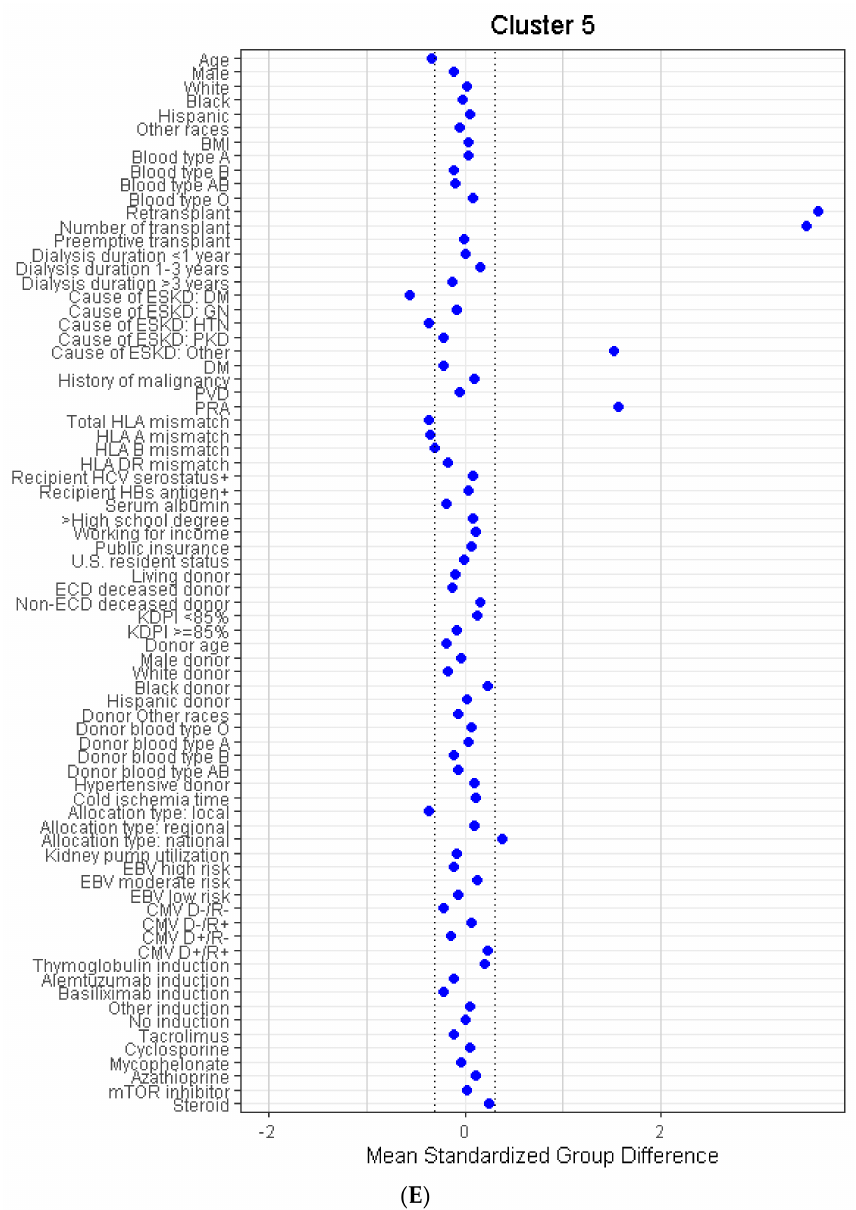
Figure 3. ( A ) The standardized differences in cluster 1 of morbidly obese kidney transplant recipients for each of the baseline parameters. ( B ) The standardized differences in cluster 2 of morbidly obese kidney transplant recipients for each of the baseline parameters. ( C ) The standardized differences in cluster 3 of morbidly obese kidney transplant recipients for each of the baseline parameters. ( D ) The standardized differences in cluster 4 of morbidly obese kidney transplant recipients for each of the baseline parameters. ( E ) The standardized differences in cluster 5 of morbidly obese kidney transplant recipients for each of the baseline parameters. The x axis shows the standardized differences values, and the y axis shows baseline parameters. The dashed vertical lines represent the standardized differences cutoffs of < − 0.3 or >0.3. Abbreviations: BMI: body mass index, CMV: cytomegalovirus, D: donor, DGF: delayed graft function, DM: diabetes mellitus, EBV: Epstein-Barr virus, ECD: extended criteria donor, ESKD: end-stage kidney disease, GN: glomerulonephritis, HBs: hepatitis B surface, HCV: hepatitis C virus, HIV: human immunodeficiency virus, HLA: human leukocyte antigen, HTN: hypertension, KDPI: kidney donor profile index, mTOR: mammalian target of rapamycin, PKD: polycystic kidney disease, PRA: panel reactive antibody, PVD: peripheral vascular disease, R: